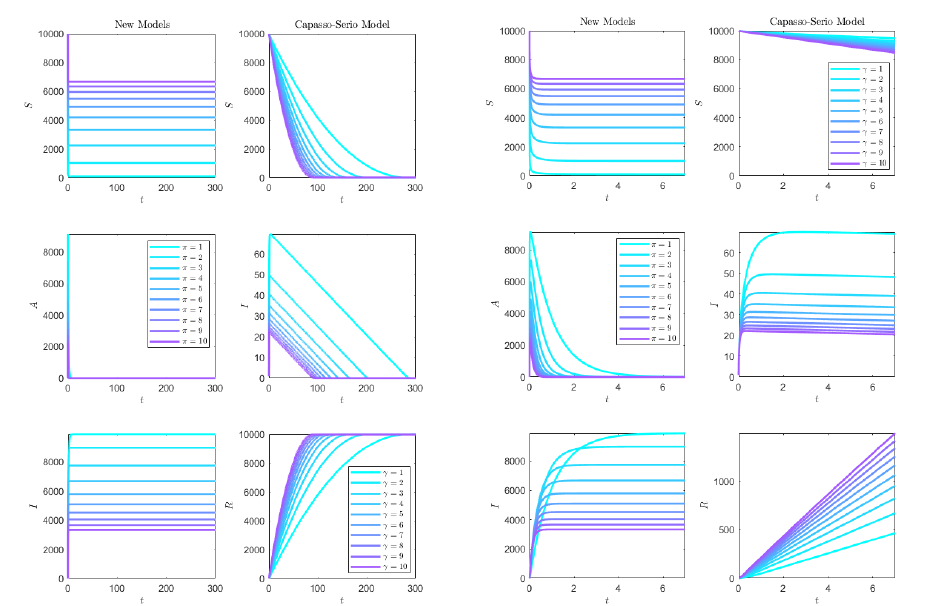
Figure 10. Here, the disease transmission rate is fixed and lower than the progression to the symp- tomatic/removed classes, with α = 0.5 < π = γ ∈ [ 1, . . . ,10 ] . Comparison between (1) (or equivalently (23)) on the left column, and the Capasso–Serio model (73) on the right column, in terms of the progression from asymptomatic to symptomatic π for (1) (as well as (23)) and of the removal rate γ for (73), with parameter values (74) and initial conditions (50). Left frame: the simulations to show the settling of the systems. Right frame: the blow up of the initial instants to better show the